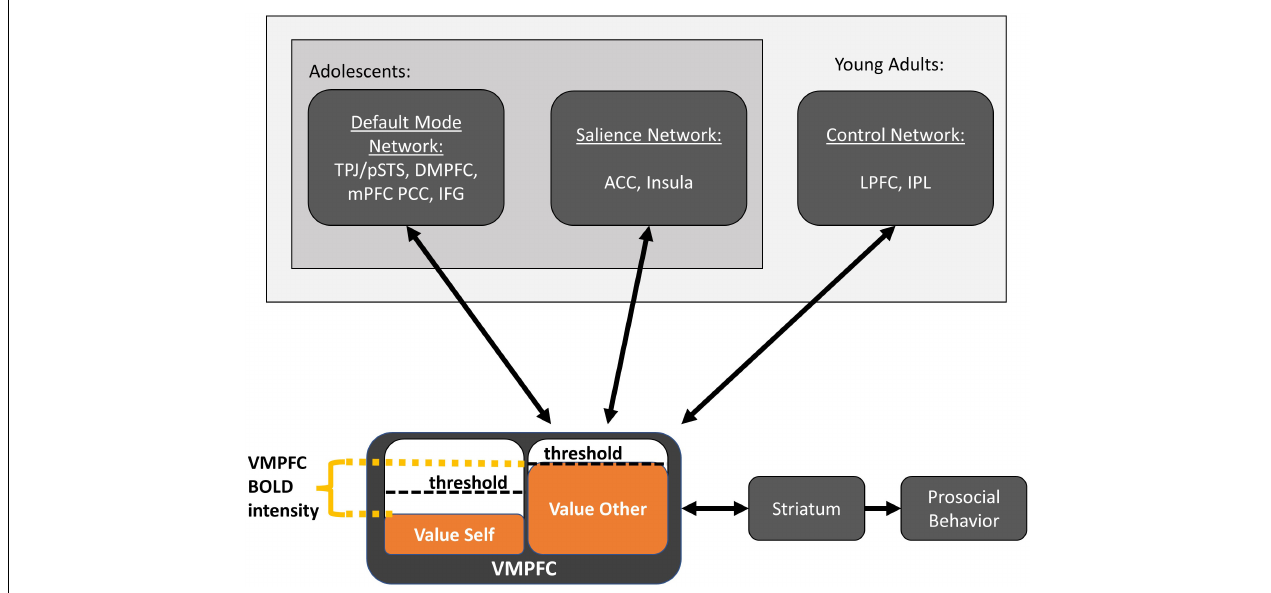
FIGURE 2 | The domain-general developmental “Do-GooD” network model of prosocial cognition. Three domain-general networks contribute value computations for prosocial decisions, which are integrated in the ventromedial prefrontal cortex. Activation in the ventromedial prefrontal cortex and striatum corresponds to the relative value between available options. Once the prosocial option reaches the decision-threshold, prosocial behavior is enacted. The default mode network predominantly computes value for self and other, and these value computations can be influenced by events that occur before the prosocial decision and may reflect general prosocial disposition. The salience network may contribute at least two types of information, one is value attributed to affect while another is self-monitoring for fairness norms, the latter of which may suppress value accrual to uphold perceived fairness. The control network computes the value for abstract desires and learned social norms and contributes this value in ways that align with those desires and norms. The control network is involved across adolescence, but importantly, it further develops through young adulthood with greater activation that increases the weight of these social norm values during decision-making. This model proposes a bidirectional process between value computation and value accrual that unfolds over many cycles in time, and where response time is proportional to the decision threshold in the ventromedial prefrontal